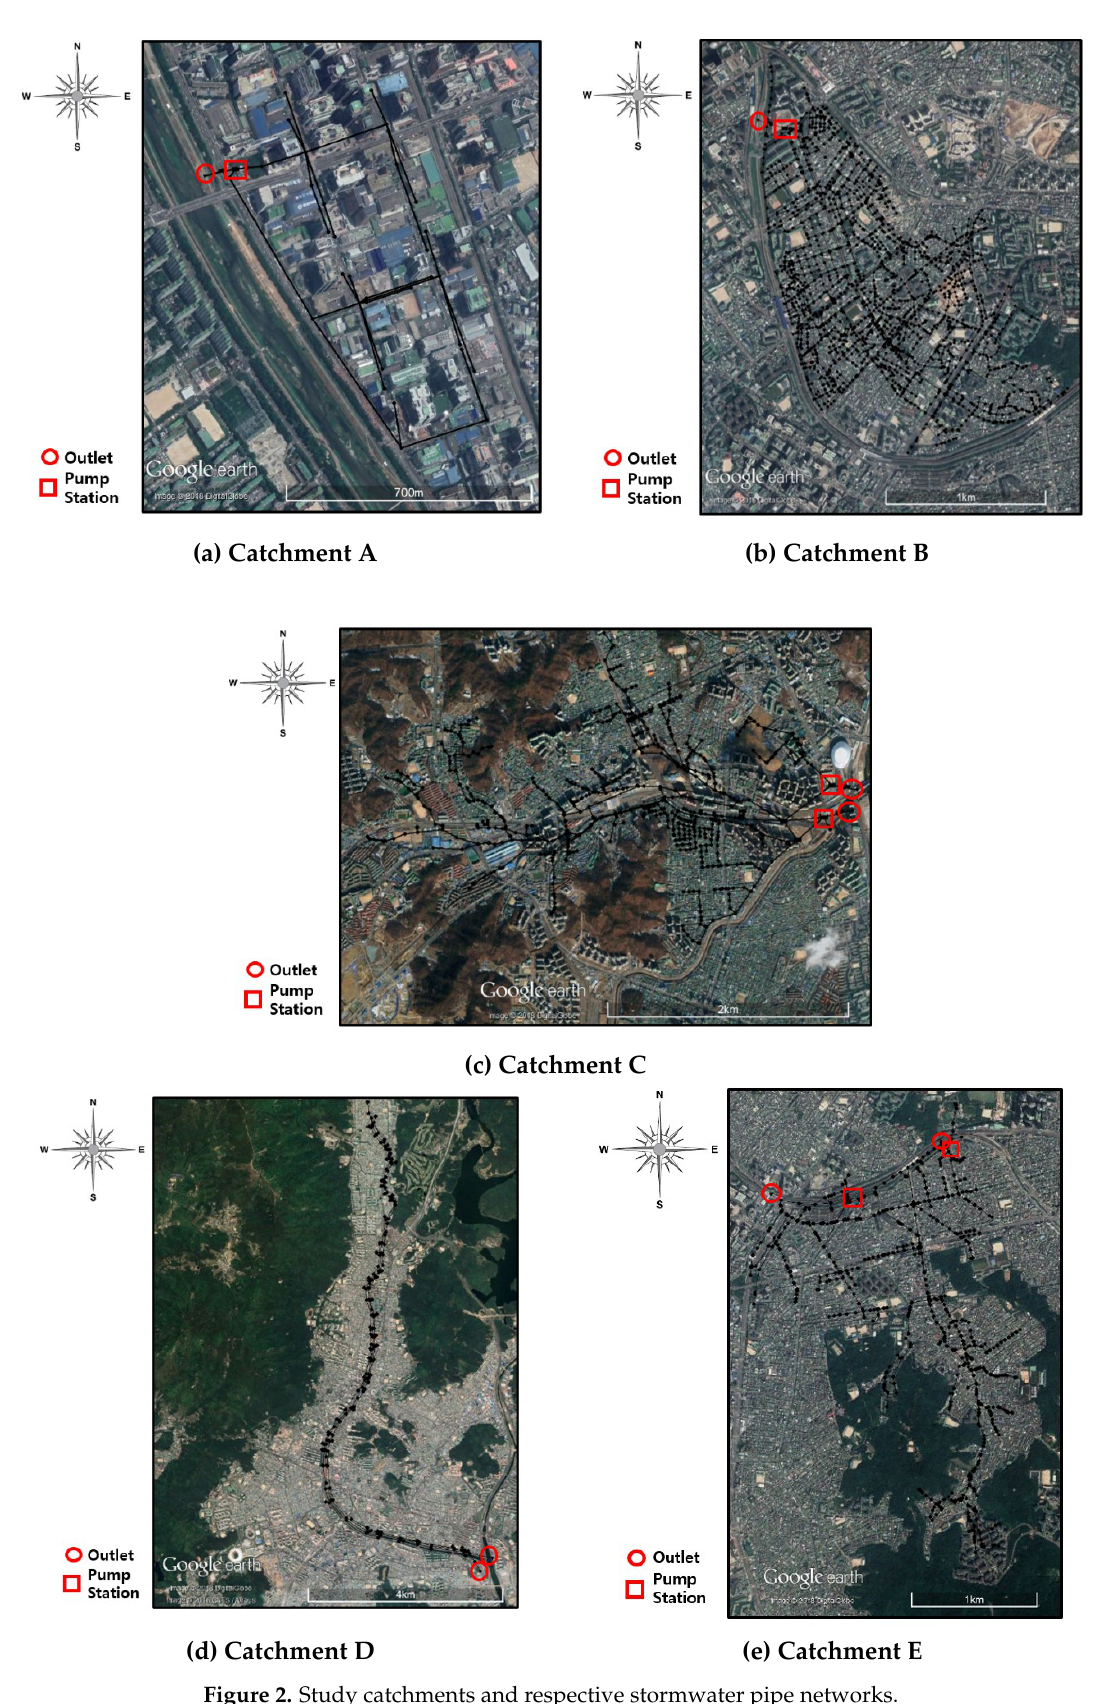
Figure 2. Study catchments and respective stormwater pipe networks. Table 2. Statistics of stormwater pipe networks in SWMM.